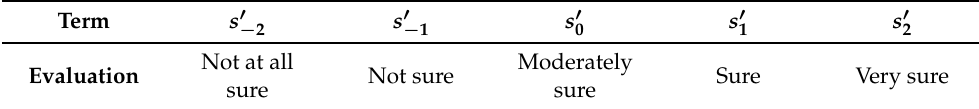
Table 4. Linguistic Term Set S (cid:48) for expressing credibility level for evaluation. Term